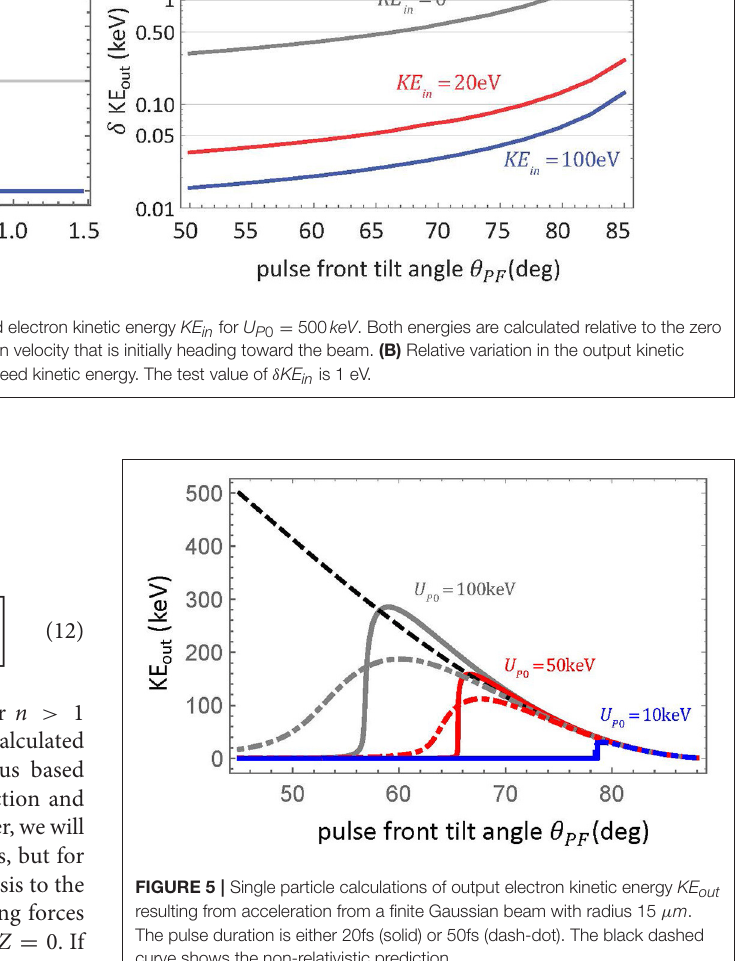
peak ponderomotive potential. For this calculation, the focal spot radius is 15 µ m and the electron starts at X 0 = 0. The solid line corresponds to a pulse duration of 20 fs , while the dash-dot line is for a duration of 50 fs . We can see that the threshold for capture is less well-defined for a finite beam size, but that a shorter driving pulse can accelerate the electrons with less time on the